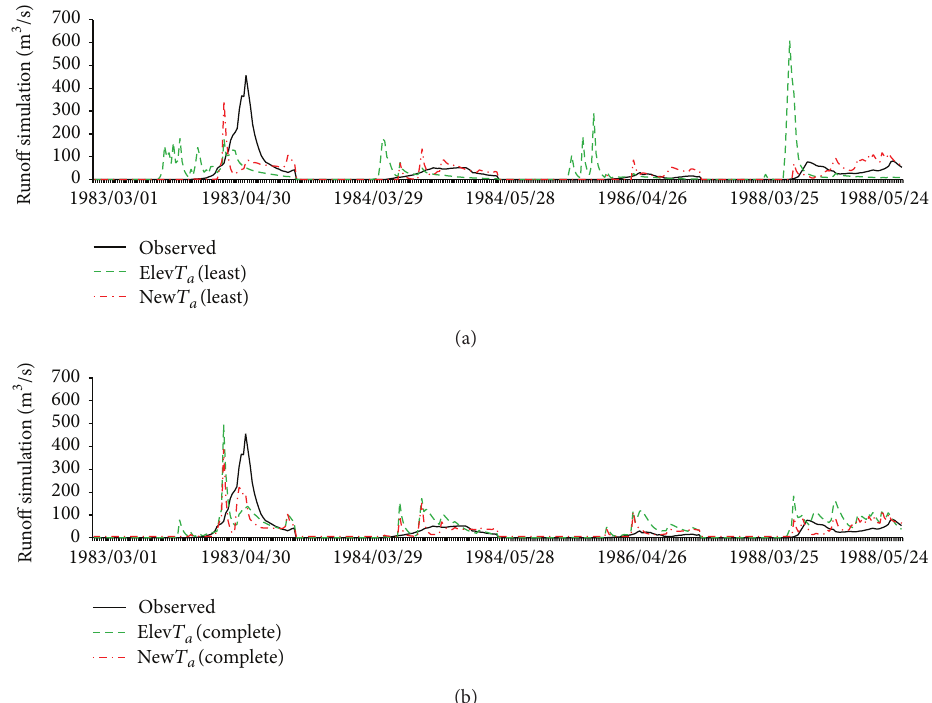
Figure 8: Spring snowmelt simulation results (March, April, and May) for the least parameters setting (a) and complete parameters setting (b) of basin A.